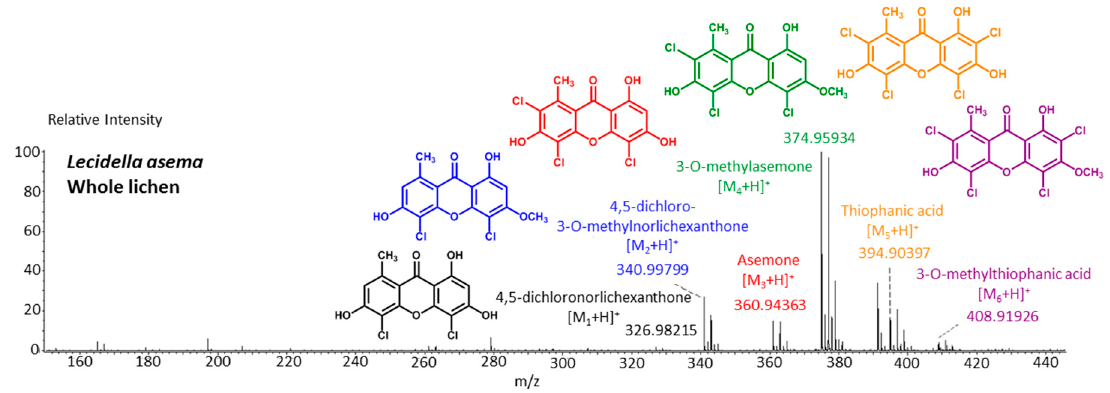
Figure 5. Positive-ion mode DART-MS spectrum of a solid piece of Lecidella asema . Experimental conditions as described in [80].